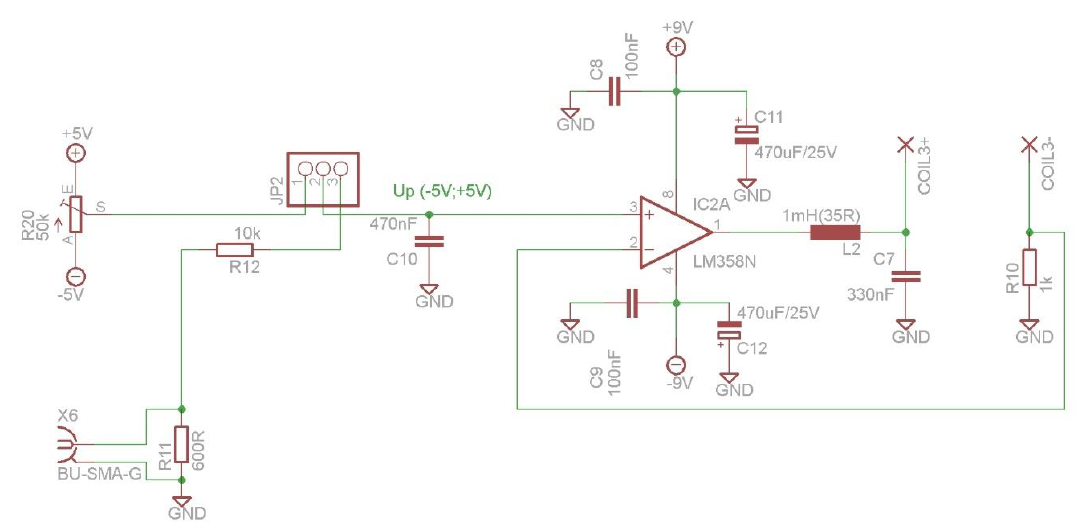
Figure 4. Electrical circuit of the current source for one pair of compensation coils, where BU-SMA-G—a female SMA connector for voltage control signal, JP2—jumper to choose the method of controlling the current source (manually via potentiometer or voltage control, e.g., via acquisition card).